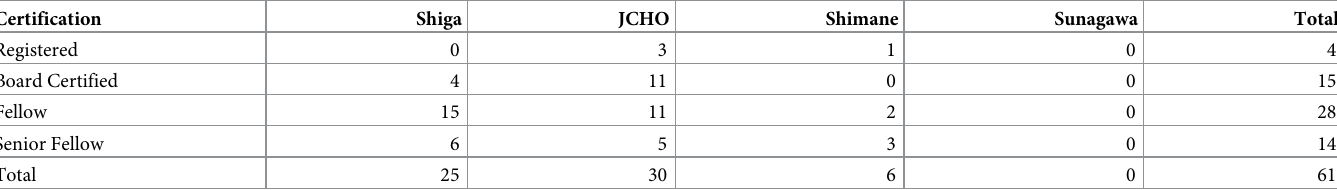
Table 3. Participant profiles by professional